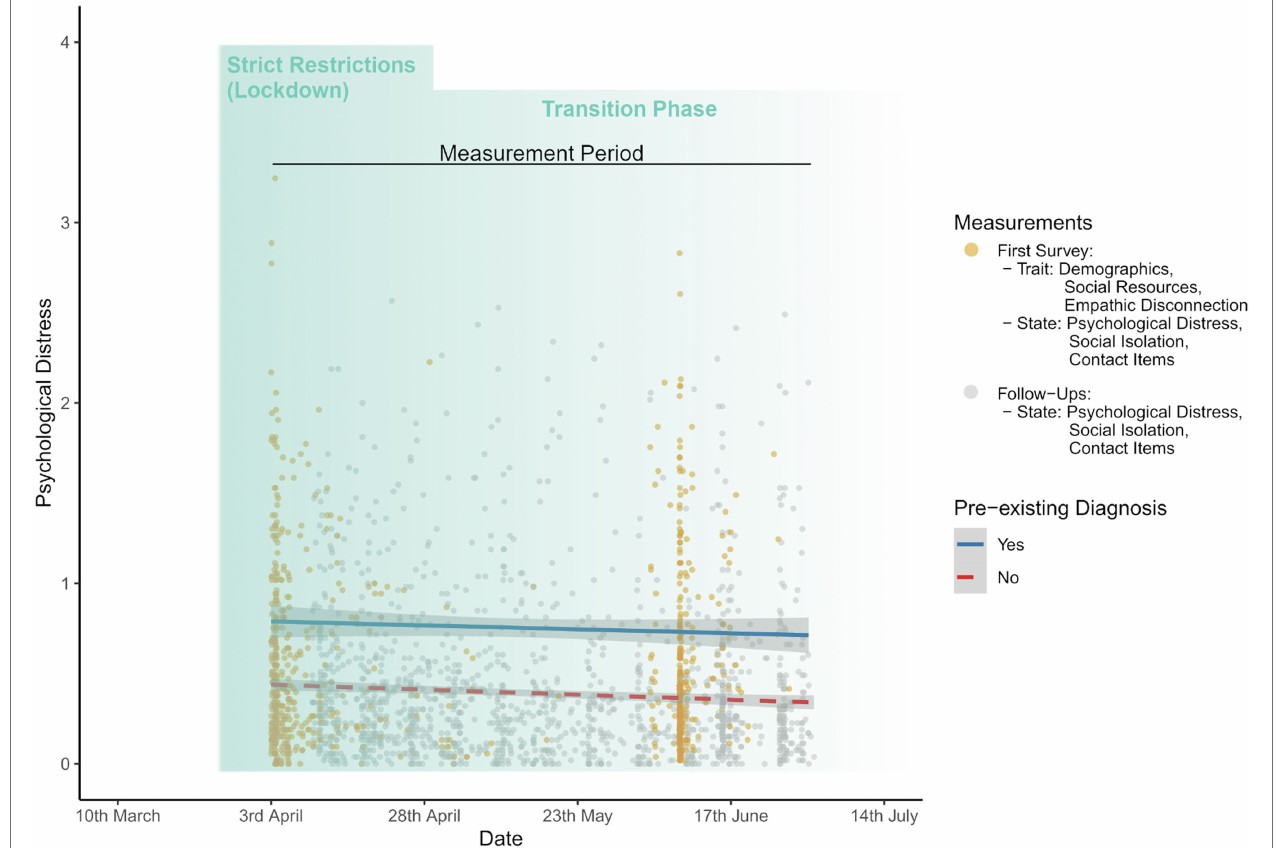
FIGURE 1 | Observations and mean psychological distress levels over time for individuals with and without pre-existing mental disorders during lockdown and transition phase of the coronavirus disease 2019 (COVID-19) pandemic in Germany. In total, n = 2,144 observations are displayed grey and yellow